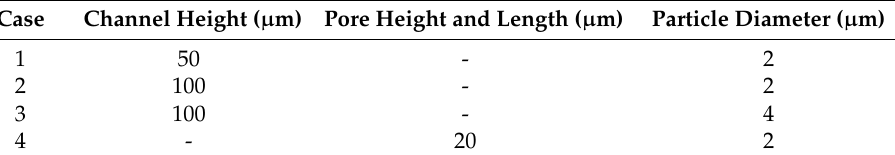
Table A1. Overview of the different dimensions used in the parameter studies.